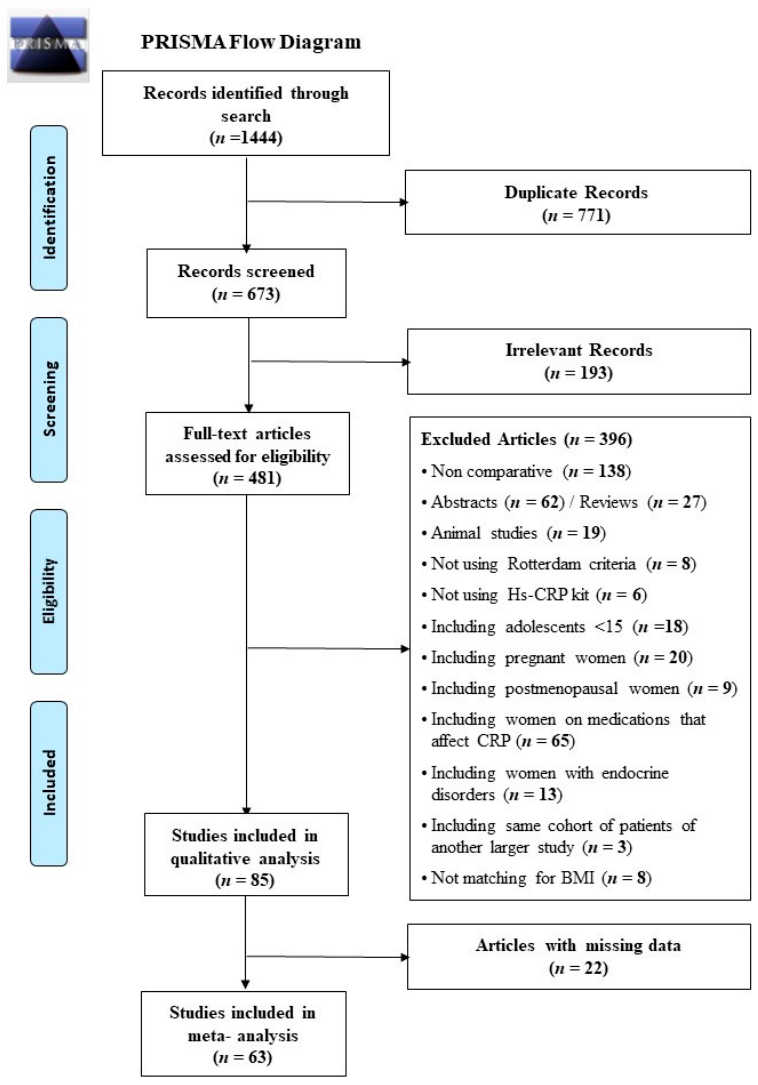
Figure 1. PRISMA Flow chart.